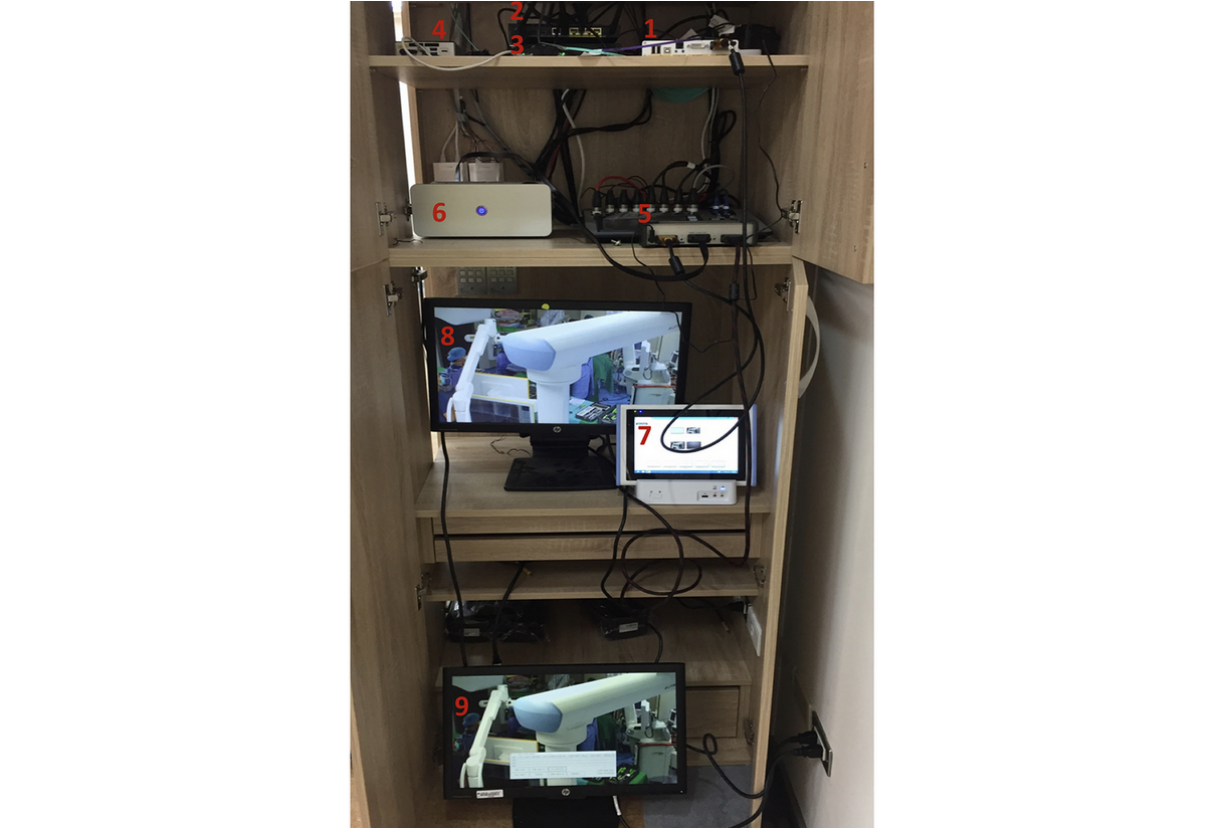
Figure 3. The equipment required for intelligent operating room streaming. (1) NDcoder (SigmaXG), (2) wireless access point, (3) 10 GB switch, (4) Intel NUC, (5) DVI splitter, (6) intelligent operating room box, (7) wireless control panel (MIT-W101), (8) medical grade display, (9) monitor for intelligent operating room box. The NDcoder was connected with the equipment in the conference room by one DVI splitter, while two other NDcoders were installed in the operating room (not shown). DVI: digital video interface; NDcoder: encoder and